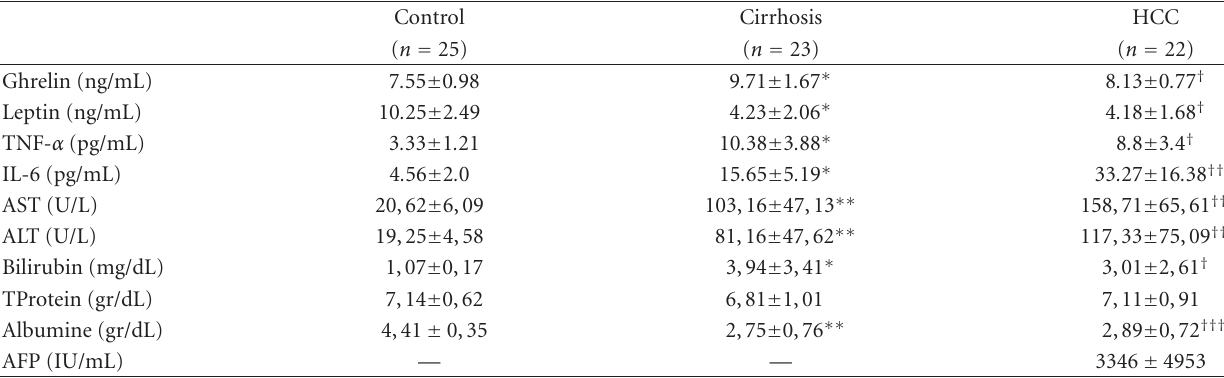
Table 2: Biochemical characteristics of control and patients groups.